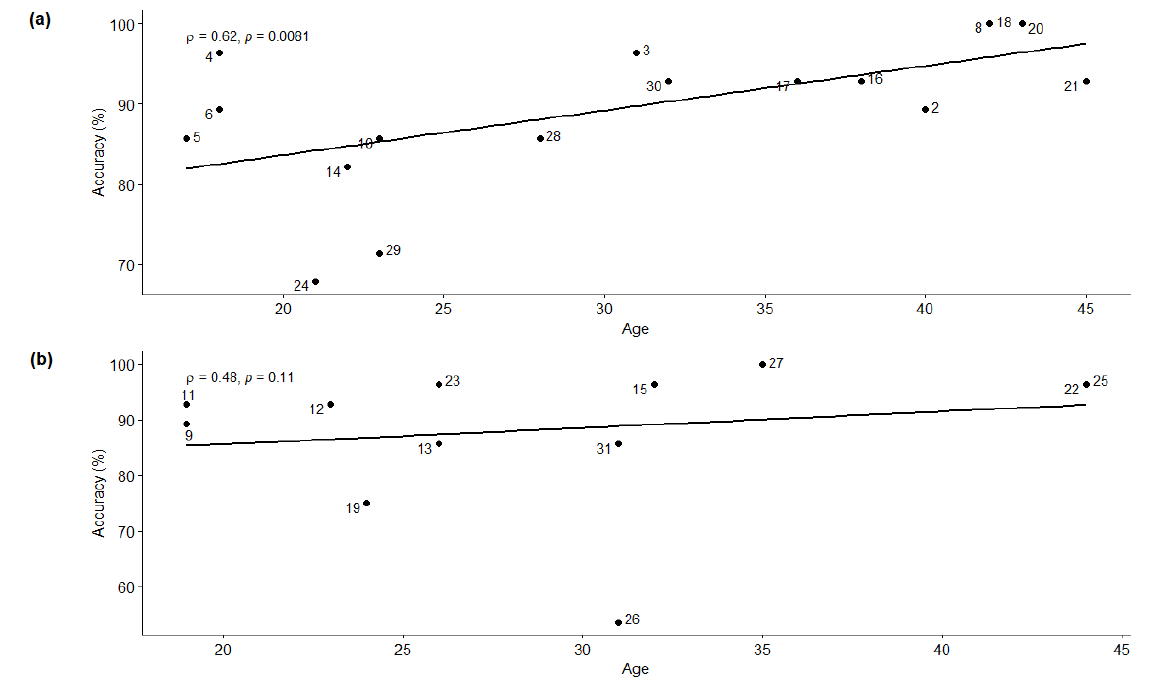
Figure 5. Scatterplots displaying the relationship between age and percentage accuracy in the identification of the contrast between /c/ and / ʧ /: ( a ) depicts results for females; ( b ) shows the results for males. Spearman’s correlation coefficient is indicated by ρ. Corresponding p -values are found to the right of each coefficient value.